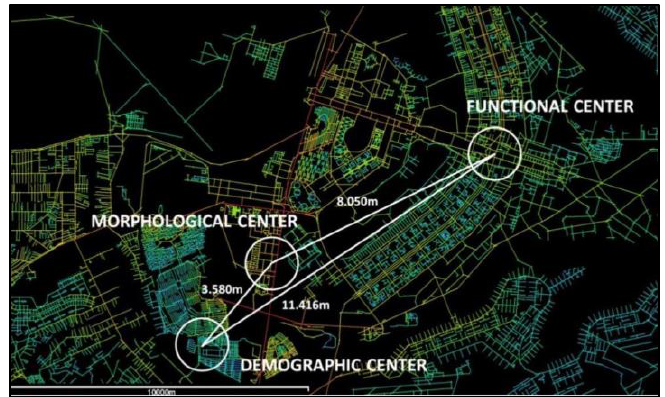
Figure 2 Deforma tion of Brasilia’s city centres obtained by Space Syntax analysis (Holanda et al.,